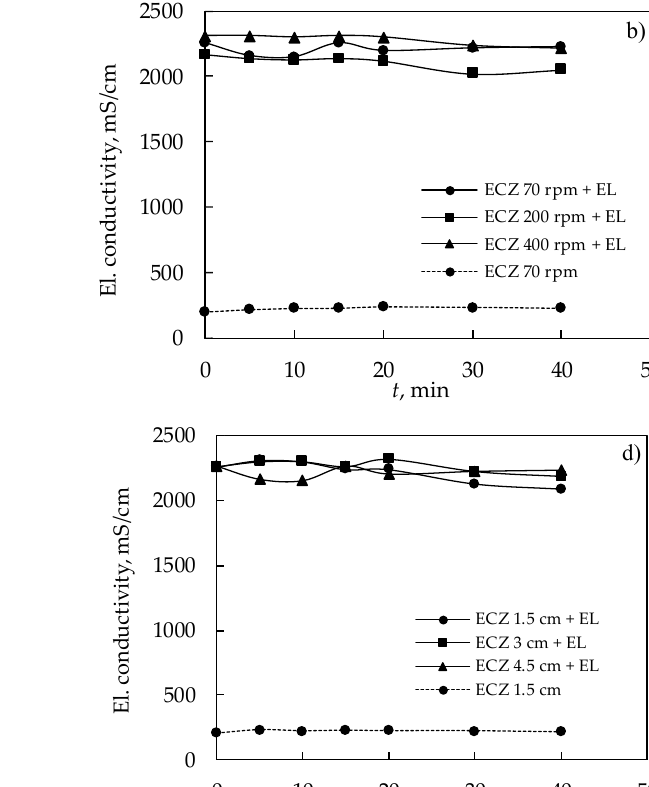
Figure 1. Change of pH values in solution during EC process at different: ( a ) stirring speed; ( b ) stirring speed with the addition of zeolite; ( c ) electrode distance; ( d ) electrode distance with addition of zeolite. Note: mark EL means the addition of electrolyte.